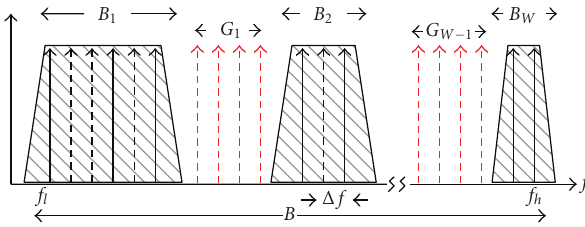
Figure 1: Illustration of the multiband analog signal to the sensing